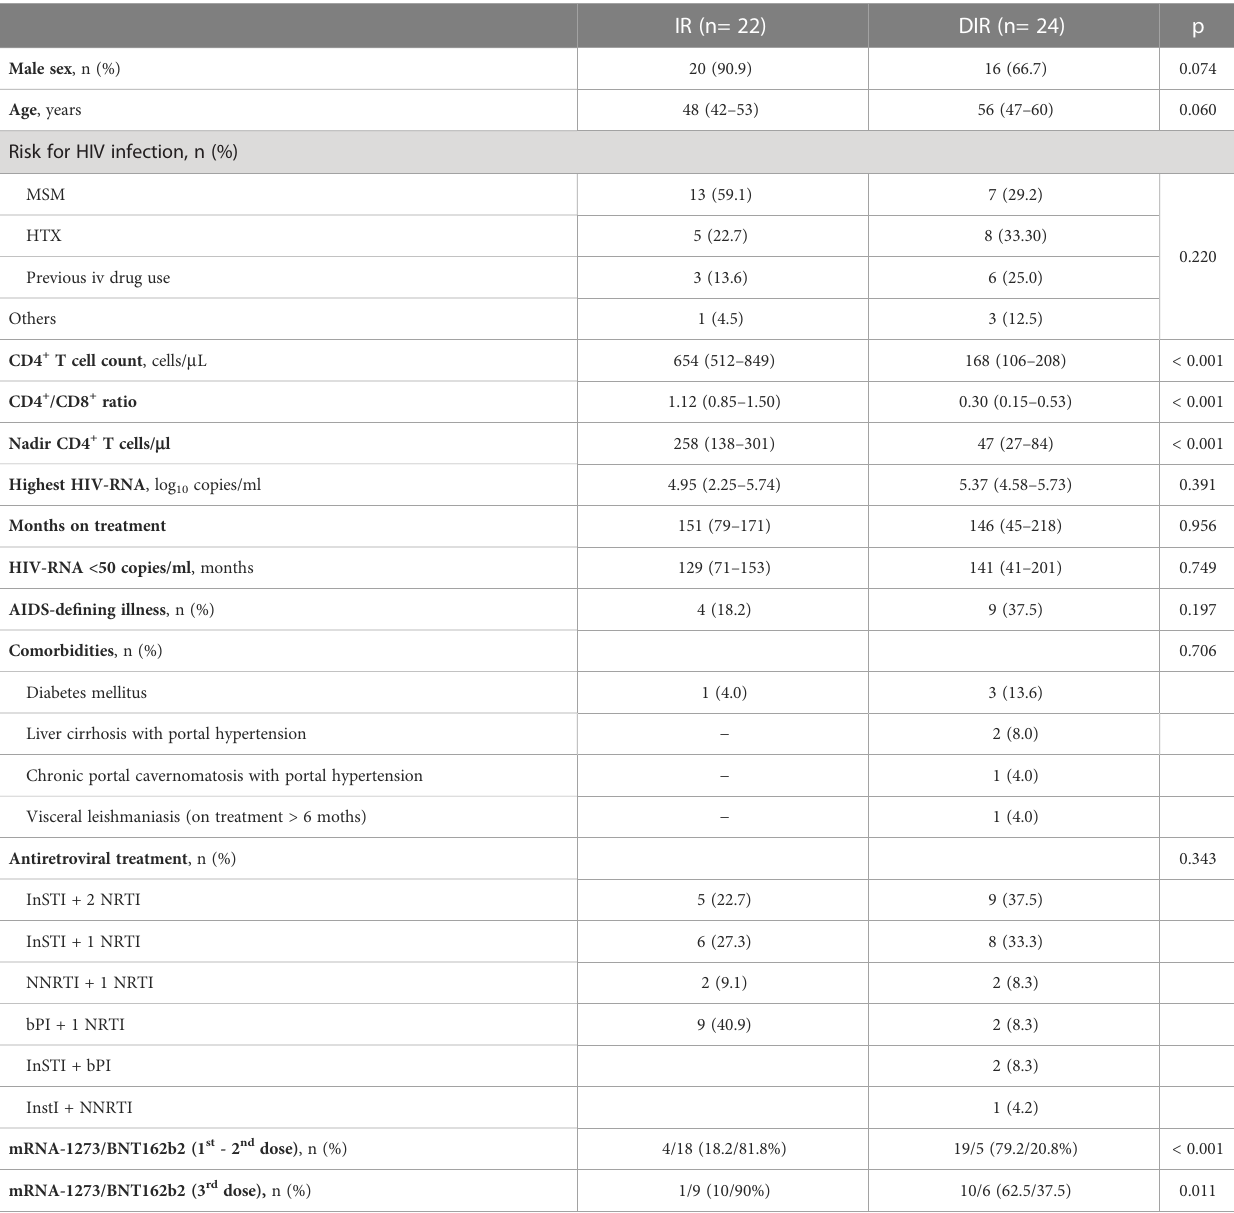
TABLE 1 Baseline demographic, clinical characteristics and vaccines